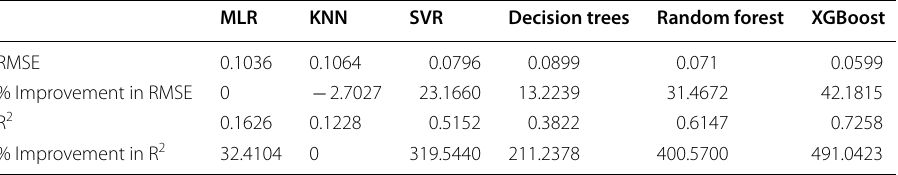
The algorithms applied in the study are evaluated based on the RMSE and R 2 values. For the RMSE, the minimum value is obtained from the XGBoost algorithm. This RMSE is 42.18% lower than that of MLR algorithm, which is the highest. For R 2 , the maximum value is obtained by XGBoost algorithm again. This R 2 is 42.18% lower than that of KNN algorithm, which is the lowest R 2 value among